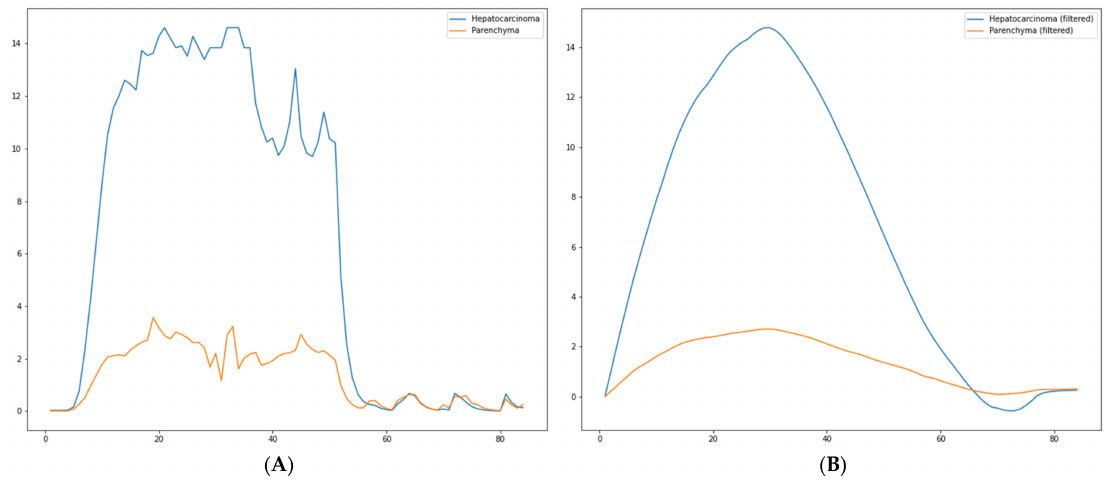
Figure 6. ( A )—Raw TIC extracted with the proposed method; ( B )—filtered TIC extracted with the proposed method (patient diagnosed with